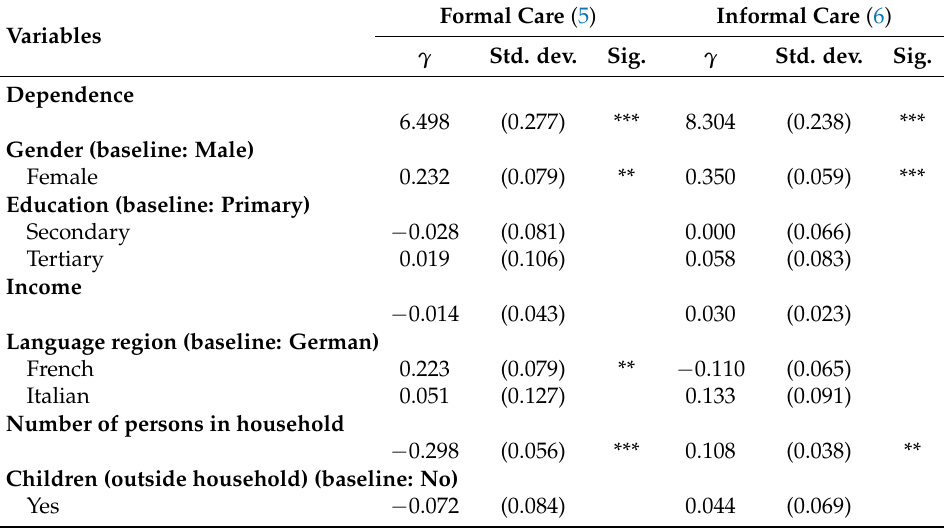
Table 8. Results for the regression models for LTC usage (models 5 and